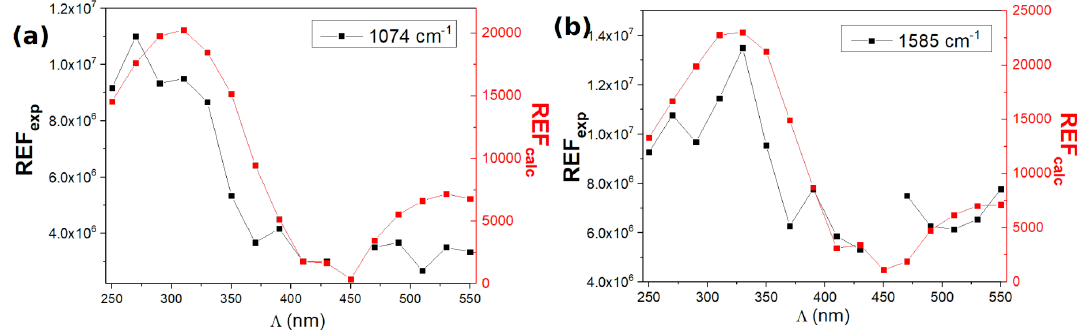
Figure 9. Experimental and calculated REF in oil for the Raman bands at 1074 cm − 1 ( a ) and 1585 cm − 1 ( b